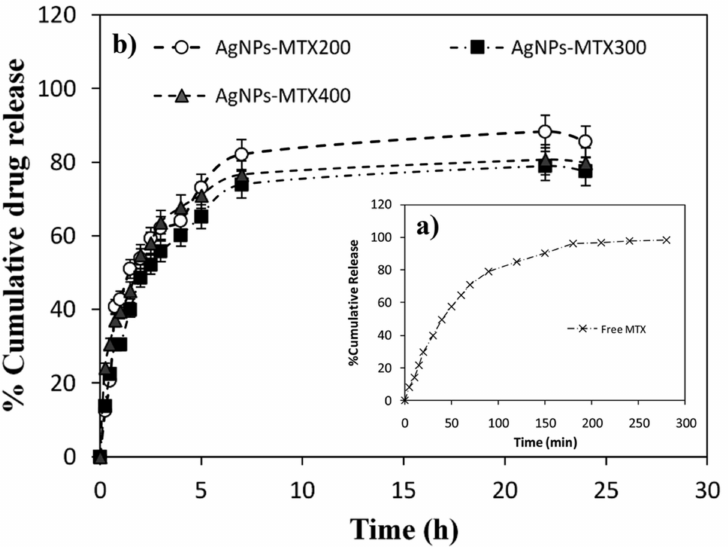
Figure 4. Release profiles of ( a ) free MTX, complete after 180 min; and ( b ) AgNPs-MTX 200, AgNPs- MTX 300, and AgNPs-MTX 400 (200, 300, and 400 refer to different initial MTX/Ag ratios). Reprinted from Ref. [73], with permission from The Royal Society of Chemistry,